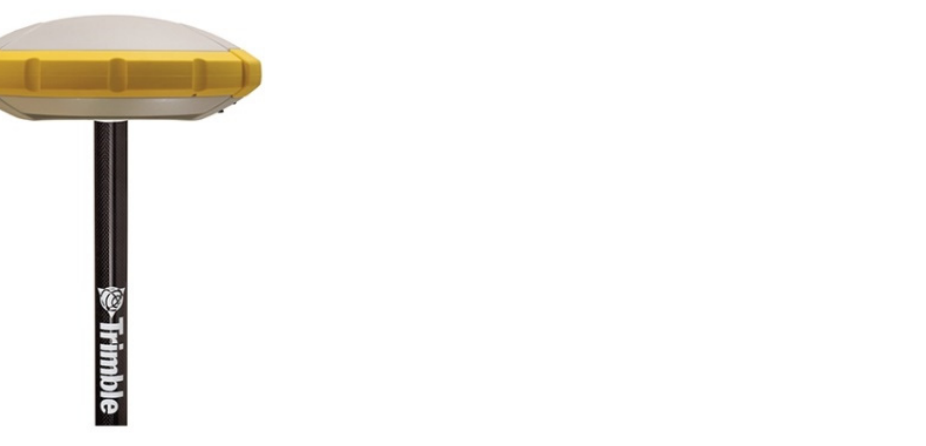
Figure 3. Trimble R4s used in Global Navigation Satellite System (GNSS) surveying. Trimble R4s can receive GNSS signals well in mountainous and urban areas with 240 channels. It enables precise measurement with a static positioning accuracy of approx- imately 3 mm and a VRS ranging from 8 to 15 mm. It has six input/output data types available, and the output of the results is possible through the USB and Bluetooth ports. Table 2 lists the detailed specifications of the Trimble R4s. Table 2. Specifications of the Trimble R4s.